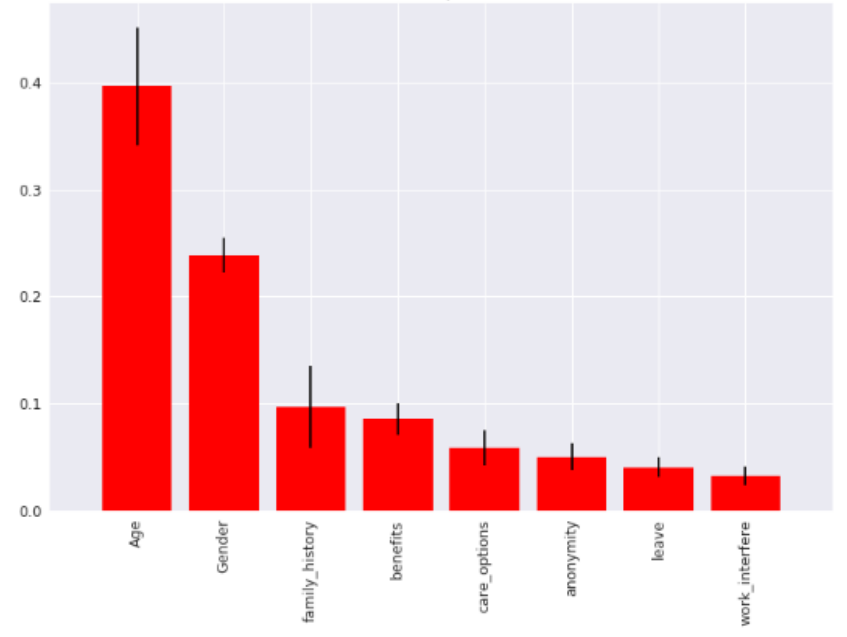
Figure 7: Importance features